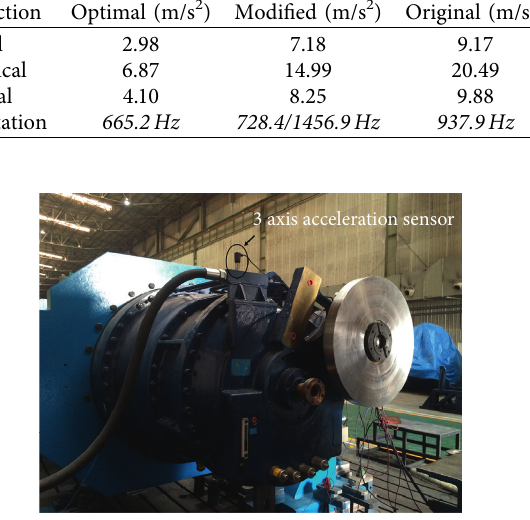
Figure 13: Primary test gearbox and sensor